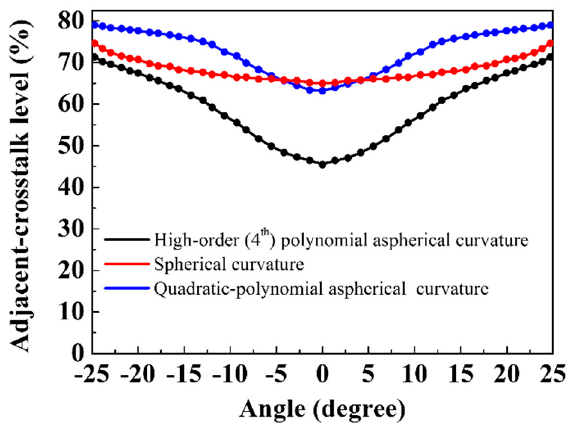
Figure 12. Angular dependence of the adjacent crosstalk level of the autostereoscopic multi-view (43-view) displays (750.6 ppi, QHD panel) comprising polarization-switchable high- ∆ n LC GRIN lens arrays with different interfacial curvatures.